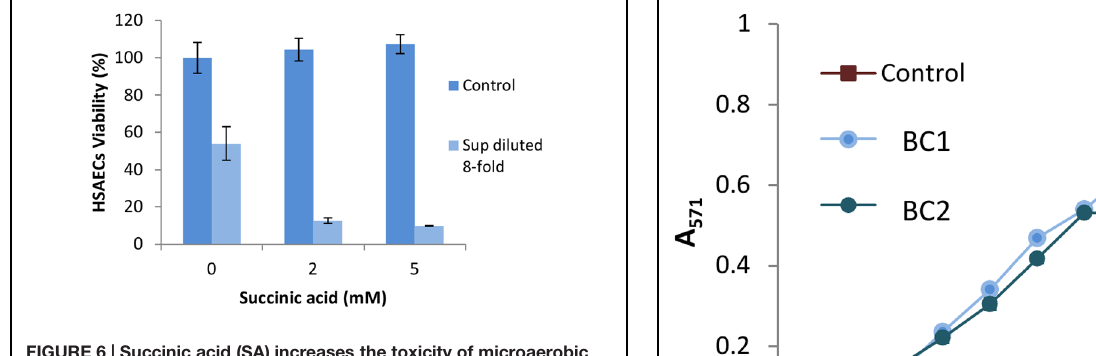
FIGURE 6 | Succinic acid (SA) increases the toxicity of microaerobic Sups grown in medium containing BSA. Strain BC1 was inoculated into DMEM medium with 1 g L − 1 of BSA and grown under microaerobic conditions for 20 h. Sups were diluted in DMEM titrated using HCl to the pH of Sups (5.4). After 20-min HSAECs exposure, Sups were removed and the cells were further incubated for 2 h at 37 ◦ C, 5% CO 2 in DMEM supplemented with 0, 2, or 5 mM SA. After incubation, medium was removed and cell viability was assessed using resazurin. Controls included the same concentration of SA in the medium titrated to pH 5.4.